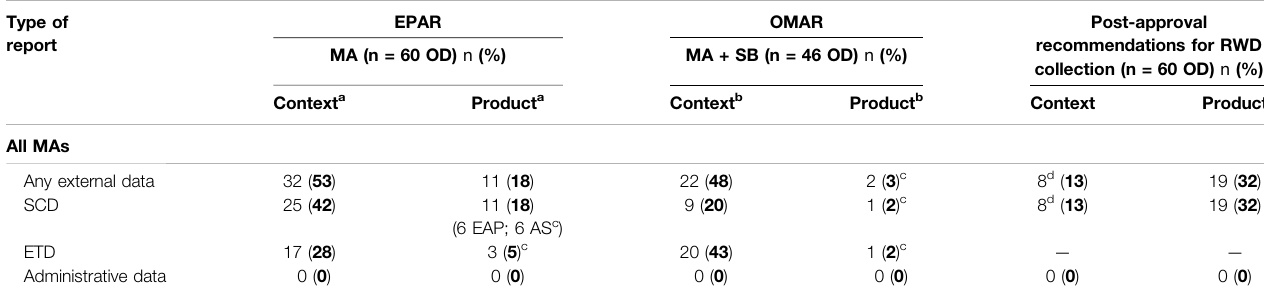
TABLE 3 | Object, source, and purpose of submission of the external data. Type of